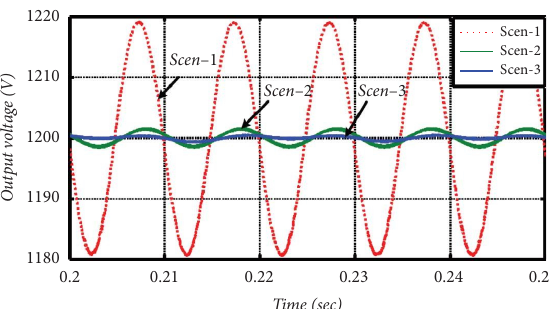
Figure 12: Output voltage for both old and suggested controller in normal and unbalanced condition.